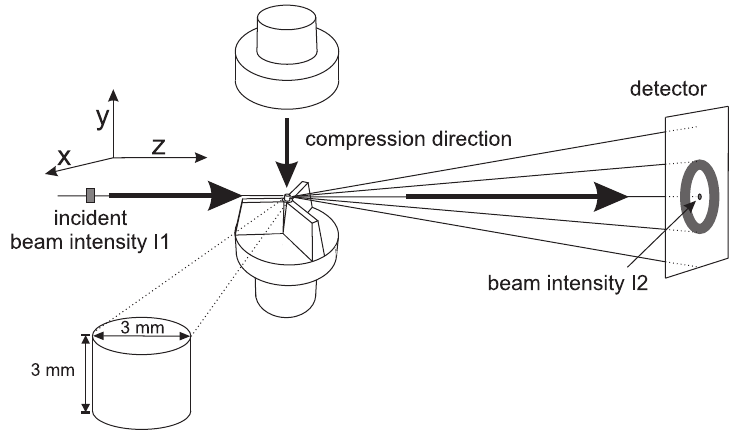
Figure 2. Schematic representation of the compression setup, combined with in situ X-ray